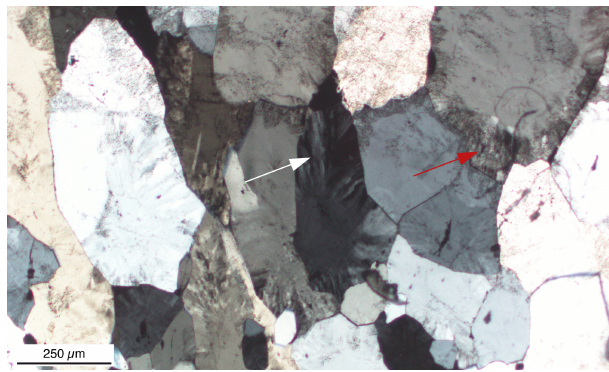
Figure 3. Photomicrograph of blocky anhedral to subhedral quartz crystals of the quartz coating from the quartz zone (Rusey Fault) showing feathery textures as indicated by the white arrow. The red arrow indicates feathery textures appearing within a zone in which a high amount of fluid inclusions is situated (non-oriented sample TY33X4; X